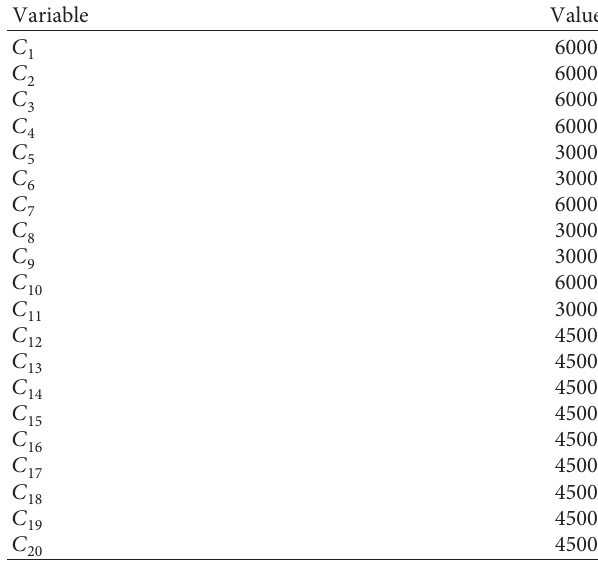
Table 10: Service rate C k in each city node.